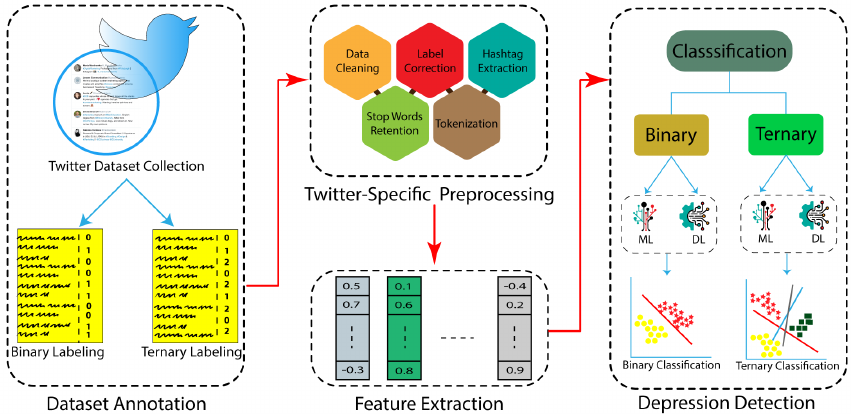
Figure 2. Methodological summary of the depression classification task.